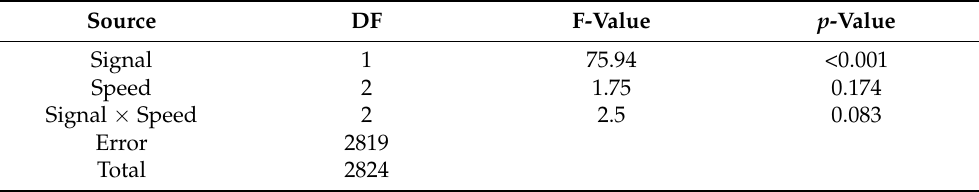
Table 4. Analysis of variance table showing the effects of signal, speed, and their interaction. Source DF F-Value p -Value Signal 1 75.94 <0.001 Speed 2 1.75 0.174 Signal × Speed 2 2.5 0.083 Error 2819 Total